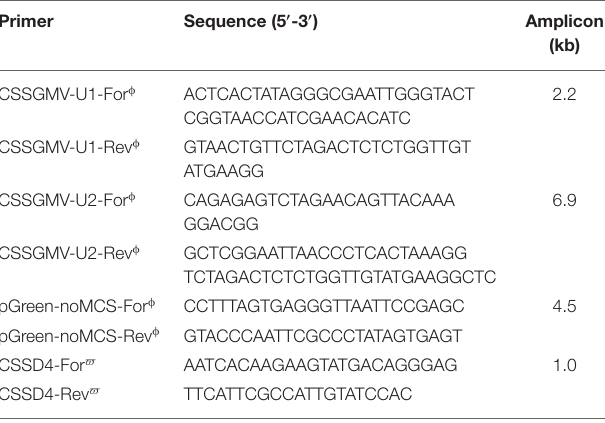
TABLE 1 | Primer sequences used for amplification of the cacao swollen shoot Ghana M virus (CSSGMV) genomic units 1 and 2, pGreenII plasmid vector, and PCR detection of